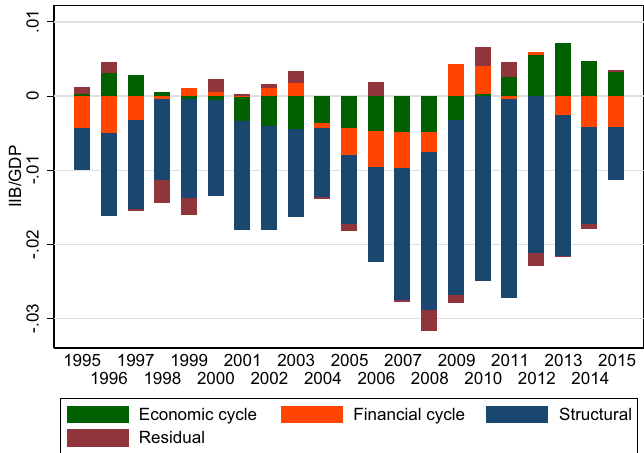
Fig.8 Level decomposition of the investment income balance. Notes. This figure plots the cyclical (proxied by the output gap—economic—and the VIX index—financial—) and structural components of the Spanish investment income balance together with the residual term identified from estimates in Table